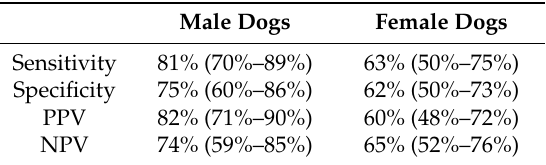
Table 5. Reliability of using 10 or more scars (in the three body zones most commonly injured in organized dogfighting) as a screening criterion for inter-dog aggression. Sensitivity, Specificity, Positive Predictive Value (PPV), and Negative Predictive Value (NPV) are provided by sex of dog, with 95% confidence